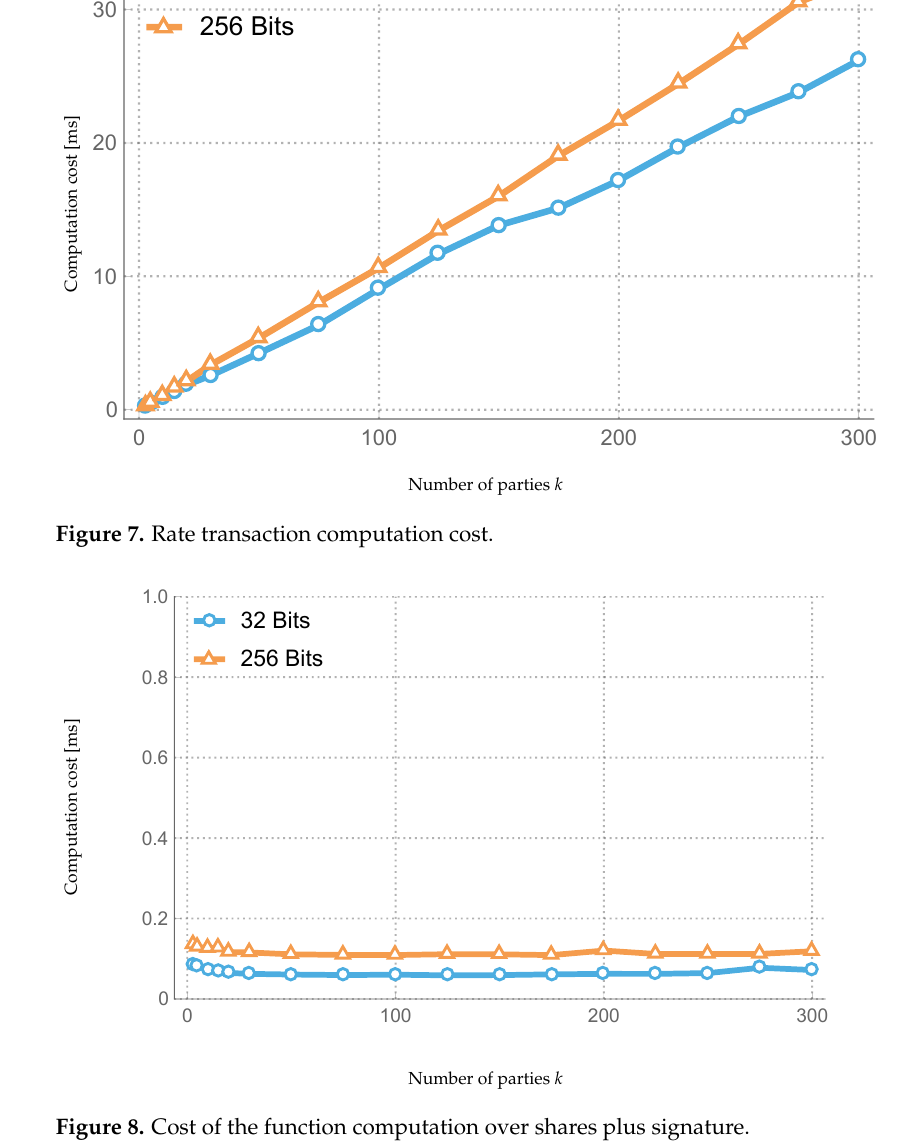
Figure 8. Cost of the function computation over shares plus